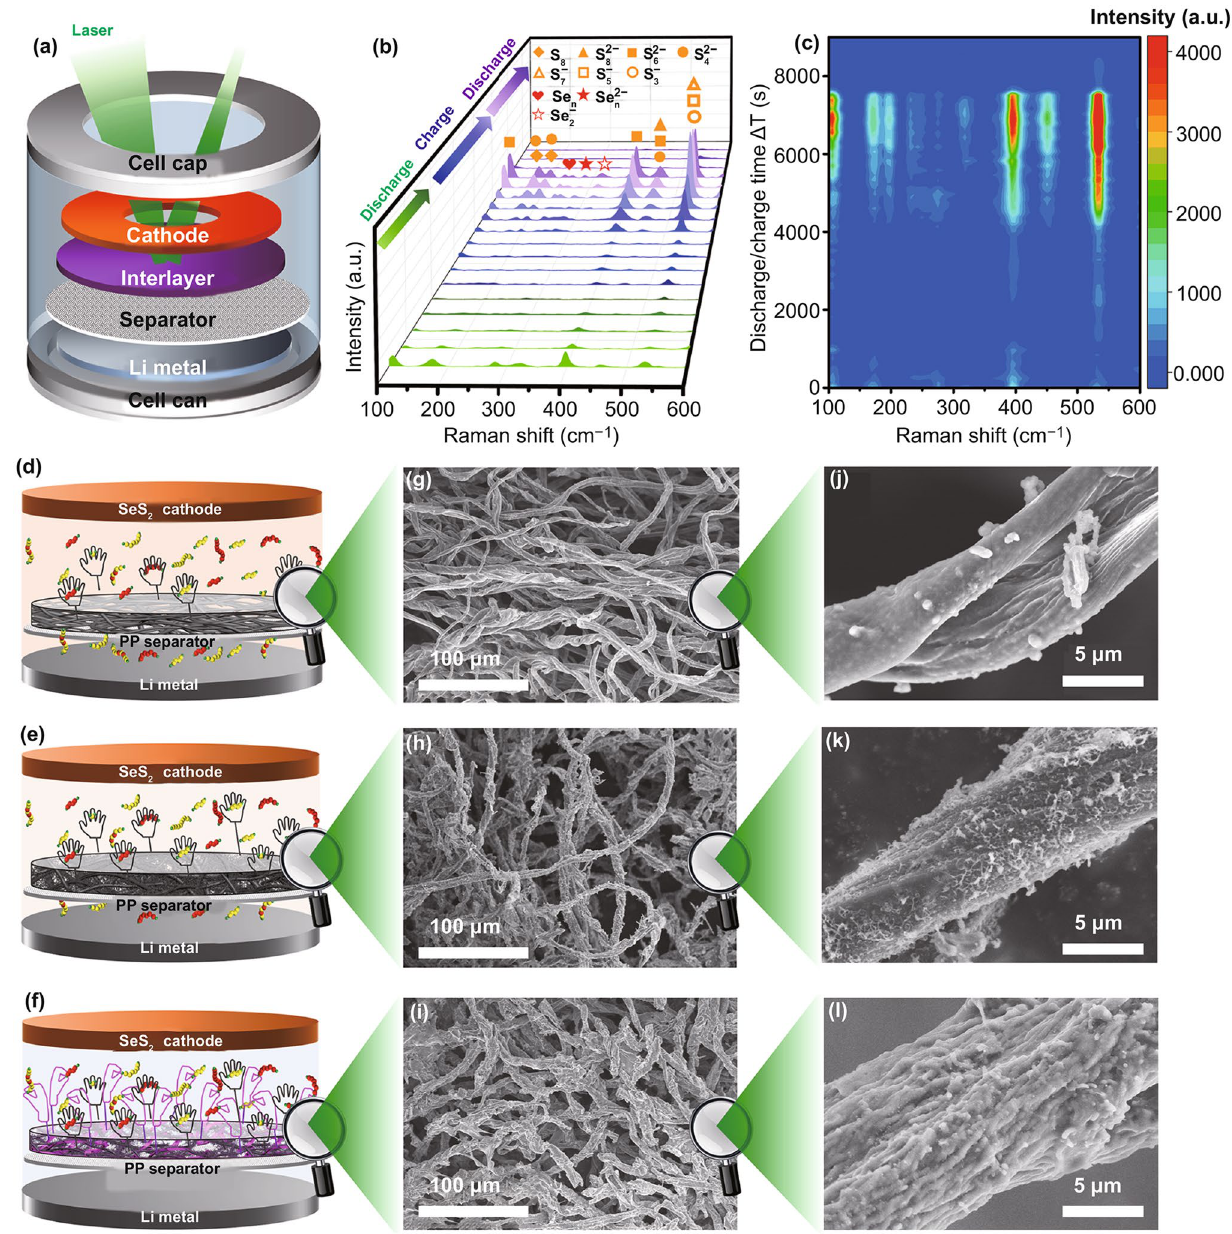
Fig. 6 a Cell configuration for Operando Raman test; b Operando Raman spectra and c the corresponding contour plot at different discharge and charge states. Schematic illustration of the operation of the Li – SeS 2 batteries with d CF, e CF@CNTs, f CF@CNTs-NPP interlayers and g–l the corresponding FESEM images of different interlayers toward the cathodes after 100